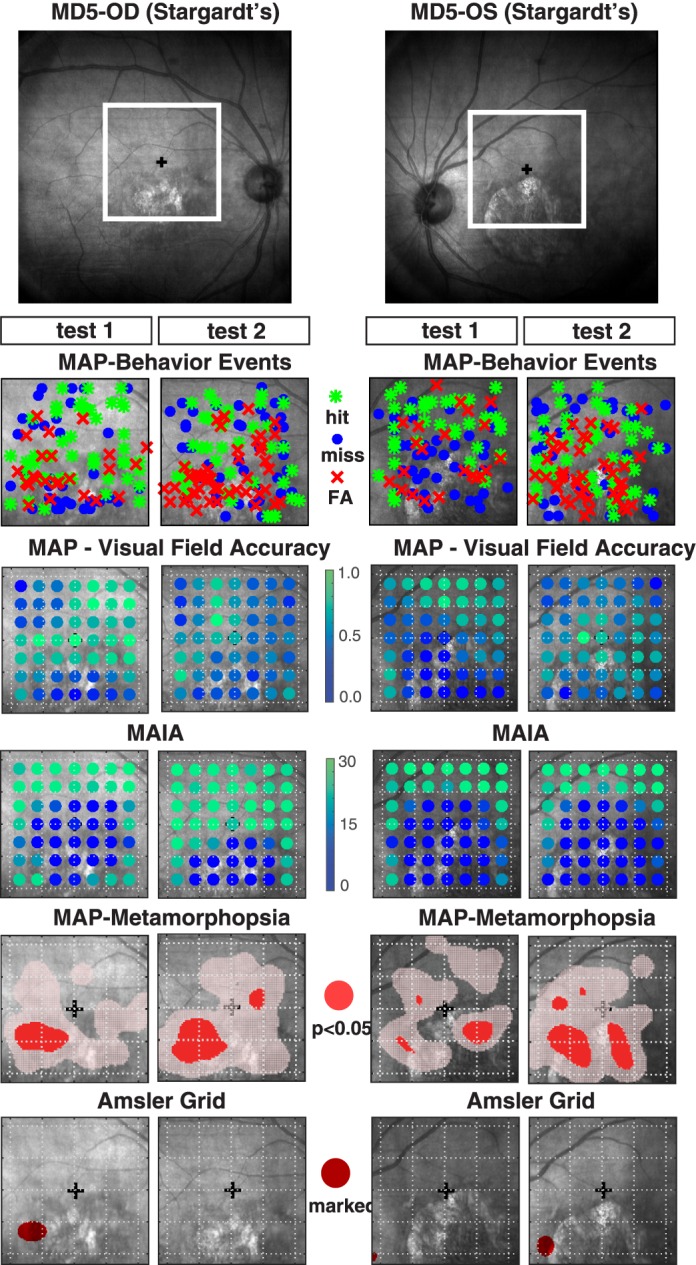
(Upper panel) Fundus image of OD and OS for patient MD5 diagnosed with Stargardt's disease with box identifying the central 14° of the visual field centered on the fovea. (Lower panels) Test measurements from test 1 and test 2 associated with MAP and MAIA, overlaid on the corresponding location of the retina centered on the fovea. MAP data were scaled, inverted, and then mirror reversed to transform from Cartesian coordinates to approximate retinal fundus image coordinates. The first lower panel shows MAP behavioral responses including FAs (red dots), hits (green dots), and misses (blue dots); the second lower panel shows MAP accuracy values resampled to the same resolution as the reference MAIA grid for direct comparison of measurements across retinal loci between the two tests. The third lower panel shows MAIA threshold sensitivity values. The fourth lower panel shows thresholded FA distortion maps, where regions marked red indicate a statistically significant degree of clustering for FA responses. The fifth lower panel shows a mirror-reversed projection of subjective Amsler grid demarcations onto the fundus image for easier visual comparison the FA distortion maps.